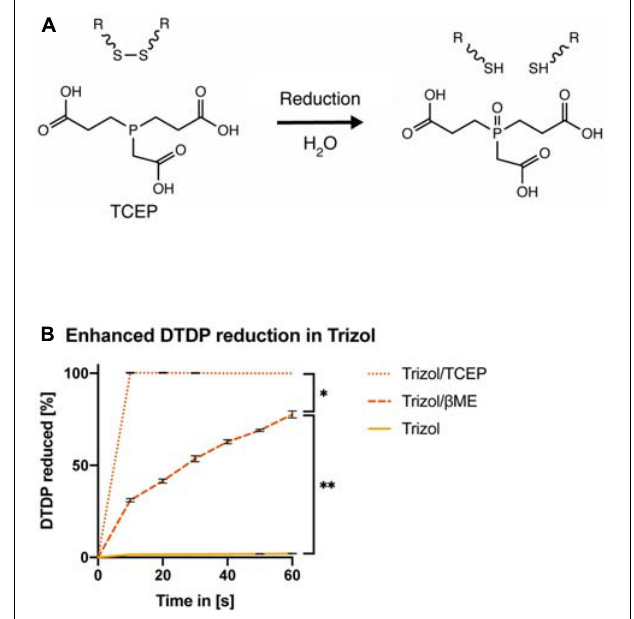
FIGURE 4 | TCEP is a potent reducing agent in AGPC lysis solution. (A) Chemical reduction of a protein disulfide bond by TCEP. (B) Measurement of DTDP reduction in % during 60 s. DTDP was rapidly reduced in Trizol supplemented with 50 mM TCEP within 10 s. Each condition was repeated 3 times ( n = 3). Data are represented as mean ± standard error of mean (SEM). Significant ANOVAs were followed by Tukey’s post hoc test, * p < 0.05, ** p <